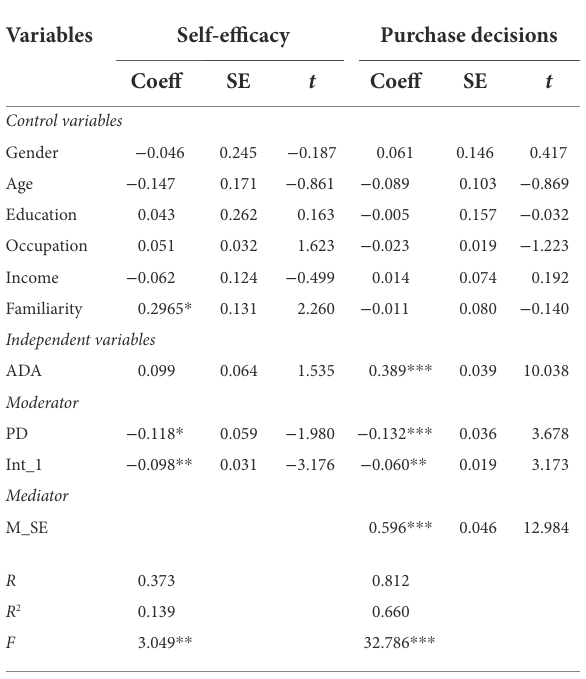
TABLE 4 Bootstrap regression results.